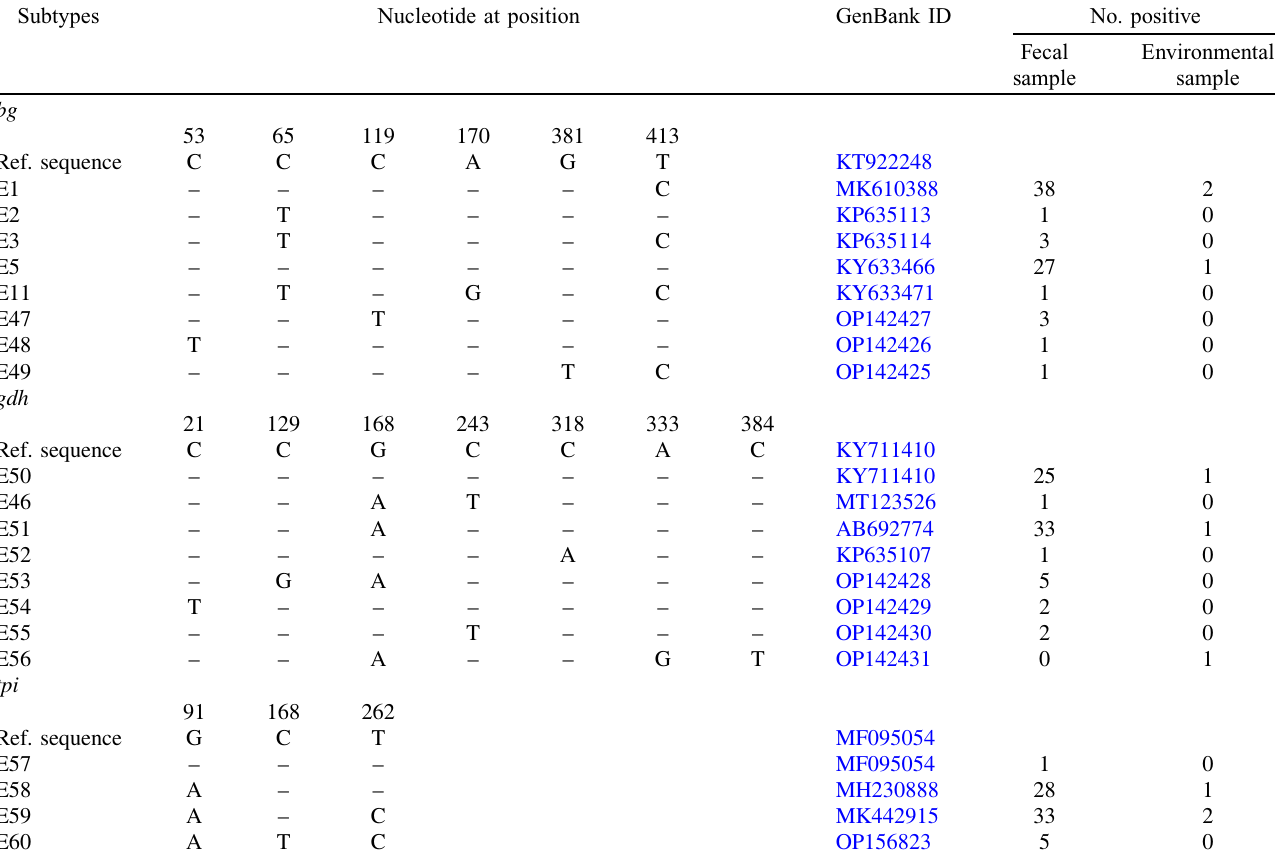
Table 3. Intra-assemblage substitutions of assemblage E at the bg , gdh , and tpi